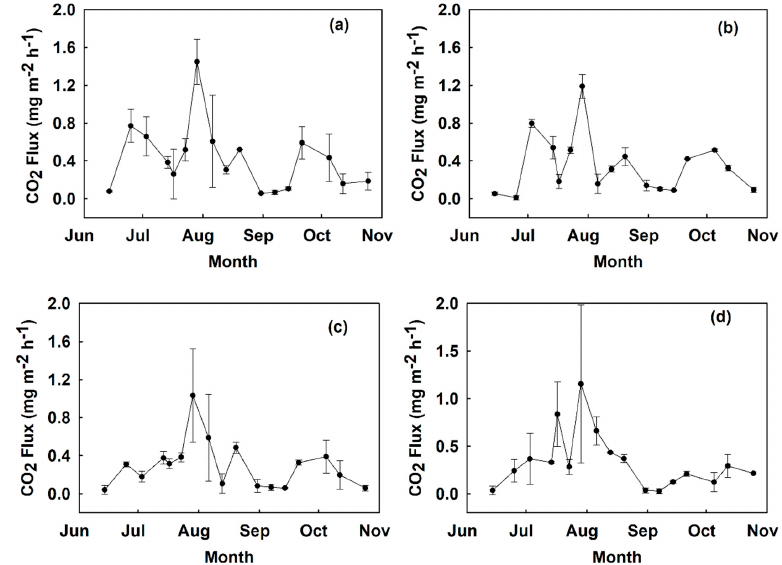
Figure 3. Time series CO 2 fluxes measured from June to October 2018 at site B in mg m − 2 h − 1 by treatment: ( a ) control, ( b ) digestate, ( c ) hydrochar, ( d ) urea. Values show a mean across two replicated plots with error bars representing the standard error.